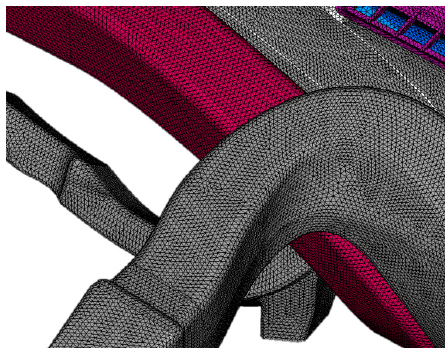
Figure 2. A three-dimensional computational model of the defrosting duct. LH (left hand), CL (center left), CC (center center), CR (center right), RH (right hand).